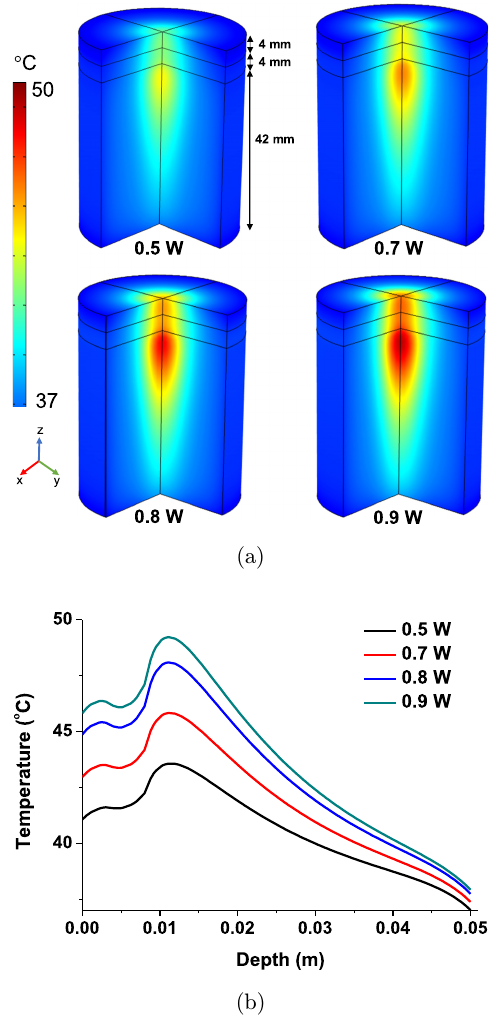
Fig. 9. (a) Temperature distribution along the depth of three-quarter skin tissue after 30 min laser irradiation and (b) Quantitative depth-wise temperature distribution along the skin tissue after 30 min laser